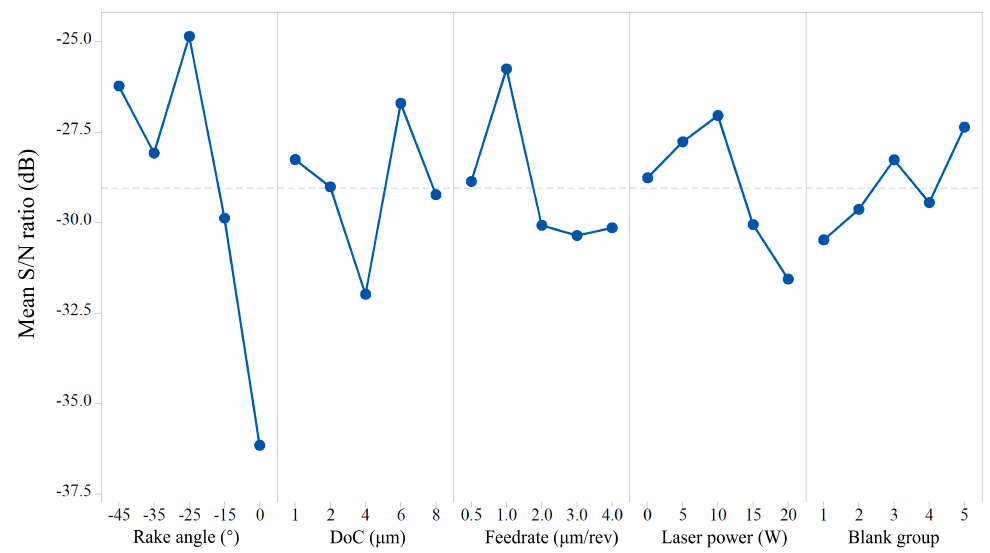
Figure 5. Main effect of mean S/N ratios corresponding to the surface roughness. Figure 5. Main e ff ect of mean S / N ratios corresponding to the surface